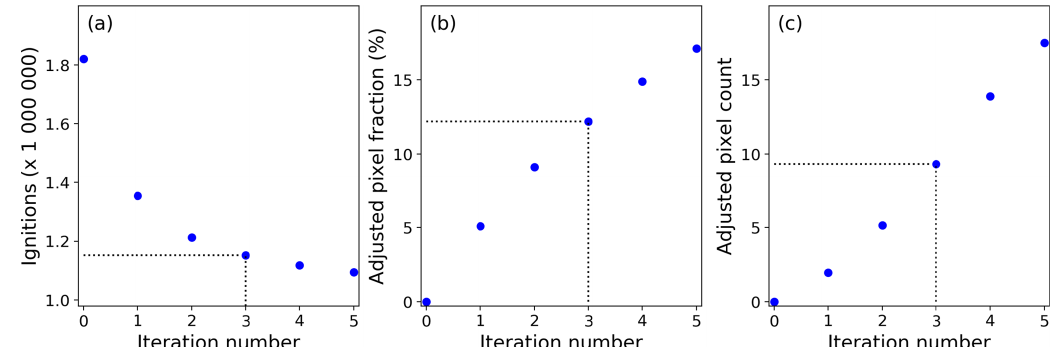
Figure A2. Trade-offs between reducing local minima not associated with ignition locations and adjustments made to the global burned-area product. (a) Local minima (ignitions) detected within the daily 500m global burned-area data for 2015 after different number of iterations of the ignition point filter, (b) corresponding fraction of burned-area pixels with adjusted burn date and (c) corresponding number of burned-area pixels adjusted divided by the reduction in ignition count. In this study, we used three iterations of the ignition point filter (indicated with the dotted lines in panels a , b and c ), and “0 iterations” refers to the original MCD64A1 Col. 6 burned-area data.